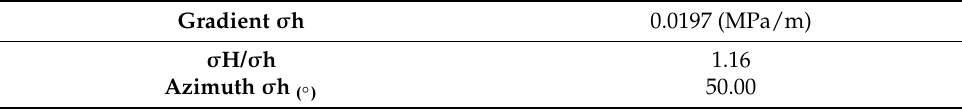
Figure 9. Analysis results of W-4 borehole images ( A) breakouts, ( B ) drilling induced fractures, ( C ) rose diagram depicting Table 3, ( D ) determined direction of the minimum and maximum horizontal stress, marked with red and blue line, respectively. Table 3. Initial principal stresses acting in Middle Cambrian